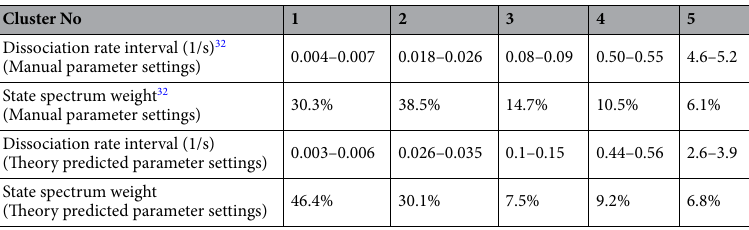
Table 2. Comparison of the inferred CDX2 spectrum with 32 . Dissociation rate interval specifies the manually assigned dissociation rate intervals corresponding to a dissociation rate cluster. The spectral weight of each of the five distinct clusters of the CDX2-spectrum was obtained by integrating the GRID amplitudes resulting from 100% of the measured survival